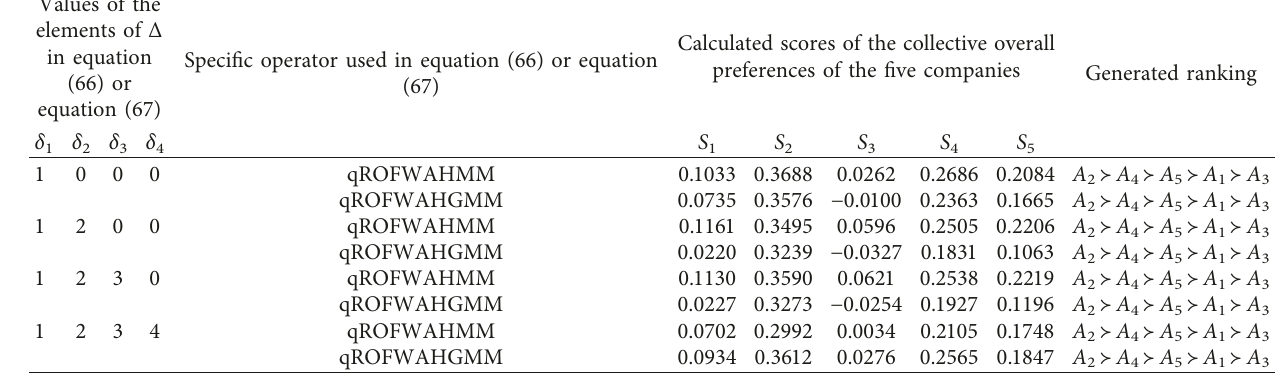
Table 2: The results of Experiment 4.